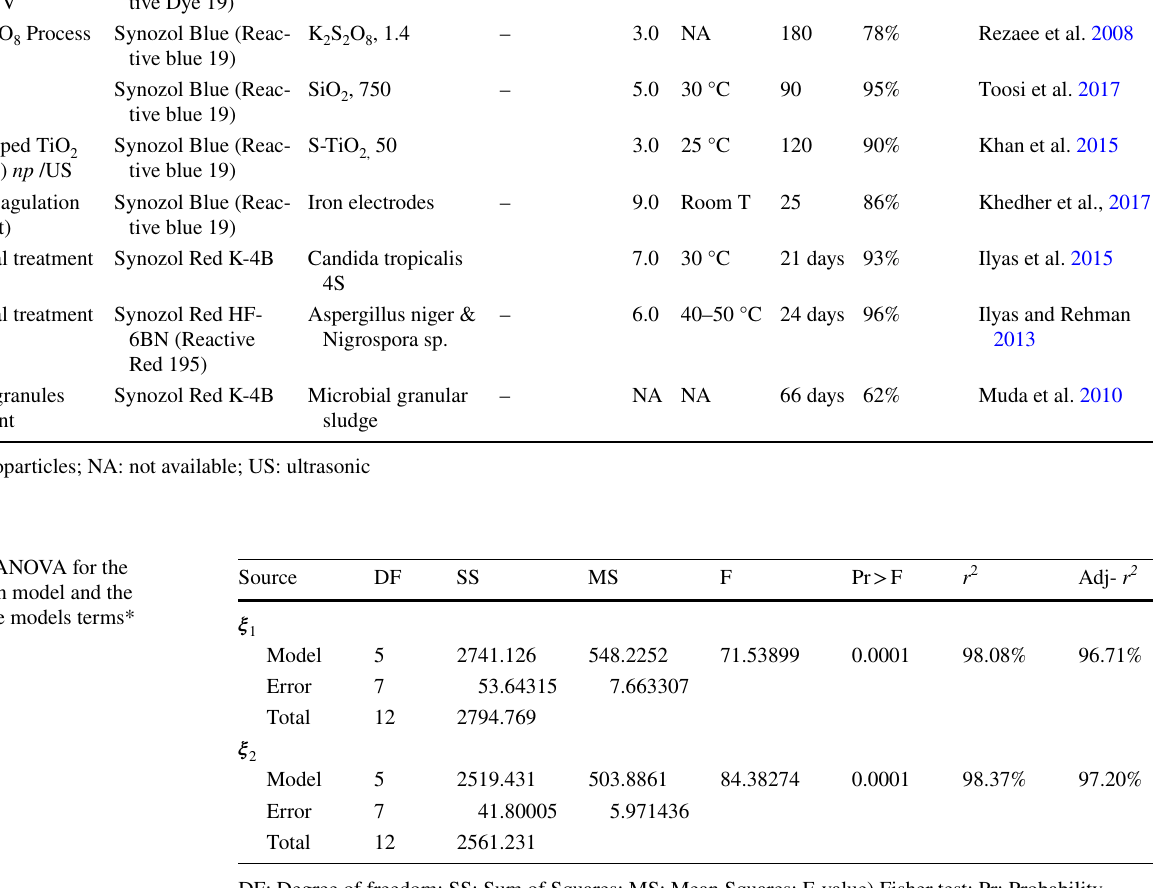
DF: Degree of freedom; SS: Sum of Squares; MS: Mean Squares; F-value) Fisher test; Pr: